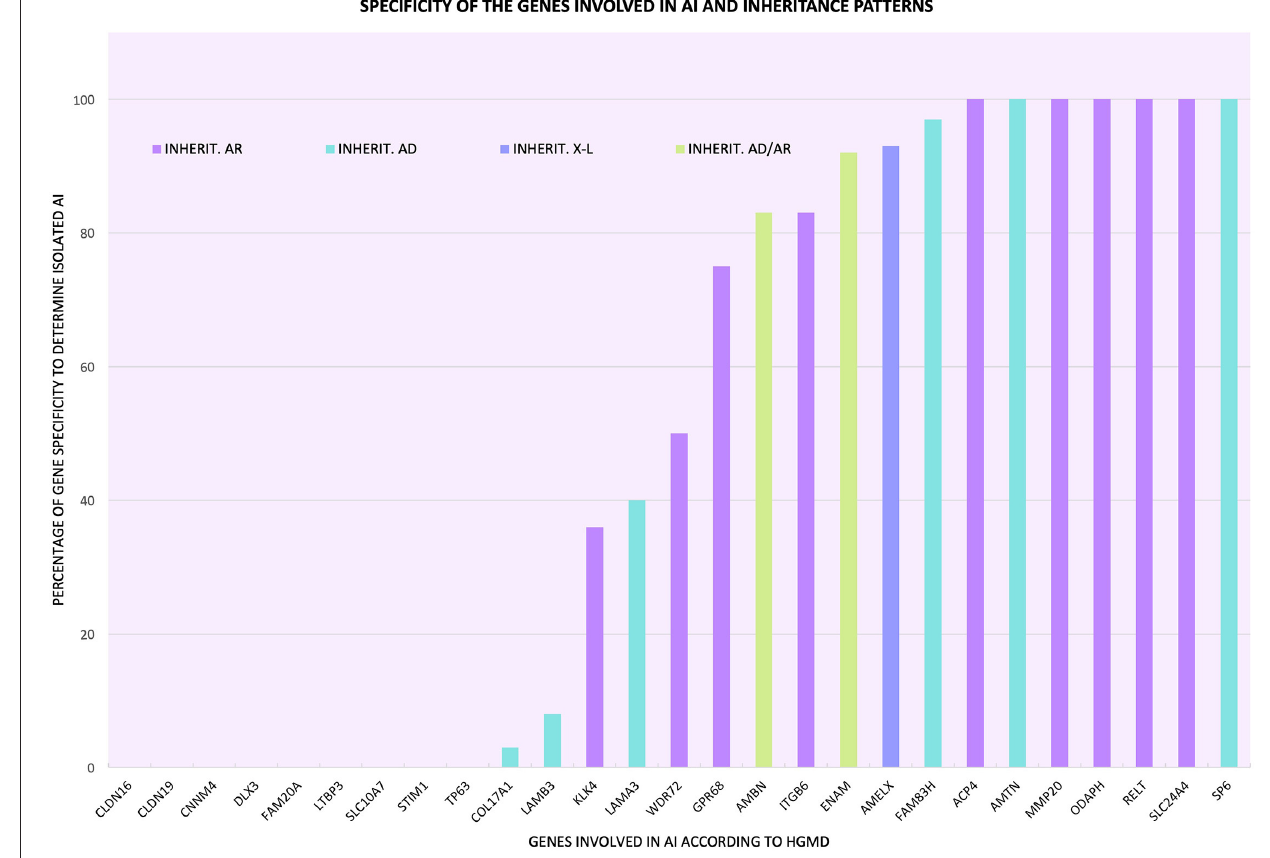
LAMA3 , STIM1 , TP63 , and SP6 genes ( Supplementary Table 1